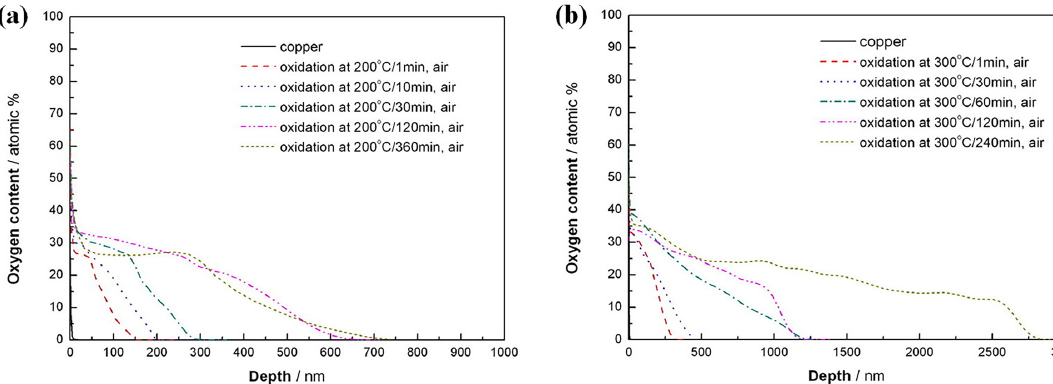
Figure 3. Oxygen profile in the Cu plates after oxidation at (a) 200 °C and (b) 300 °C in air for various durations